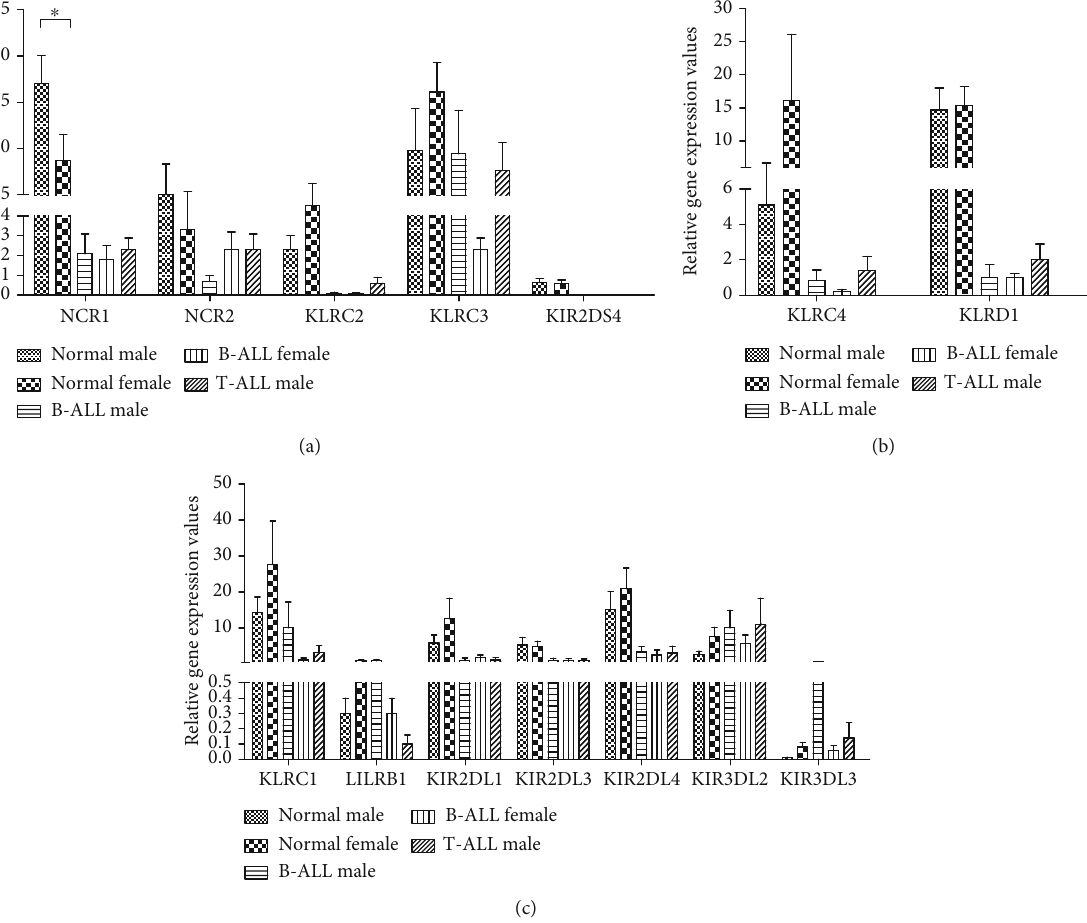
Figure 3: (a – c) mRNA expression of activating receptors in normal male controls ( n = 12 ), normal female controls ( n = 12 ), B-ALL male patients ( n = 12 ), B-ALL female patients ( n = 12 ), and T-ALL male patients ( n = 14 ) using qPCR. Data are presented as mean ± standard errorof mean . Mann-Whitney U test compared mean between two groups. “ ∗ ” indicates statistical signi fi cance p < 0 : 05 and “ ∗∗ ” indicates statistical signi fi cance p < 0 : 001